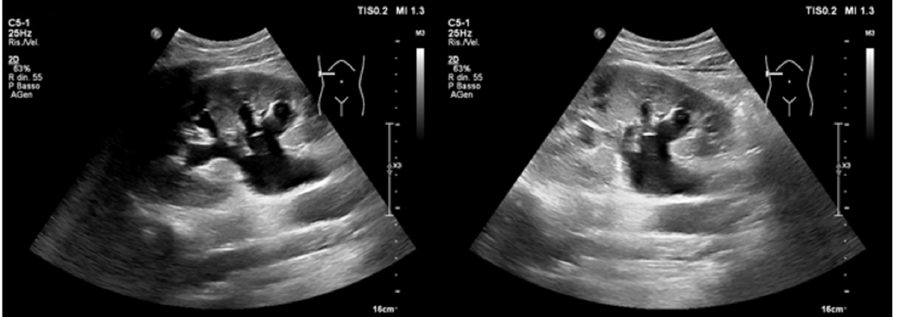
Figure 11. Pelvis and caliceal dilatation with proximal ureteral stone.